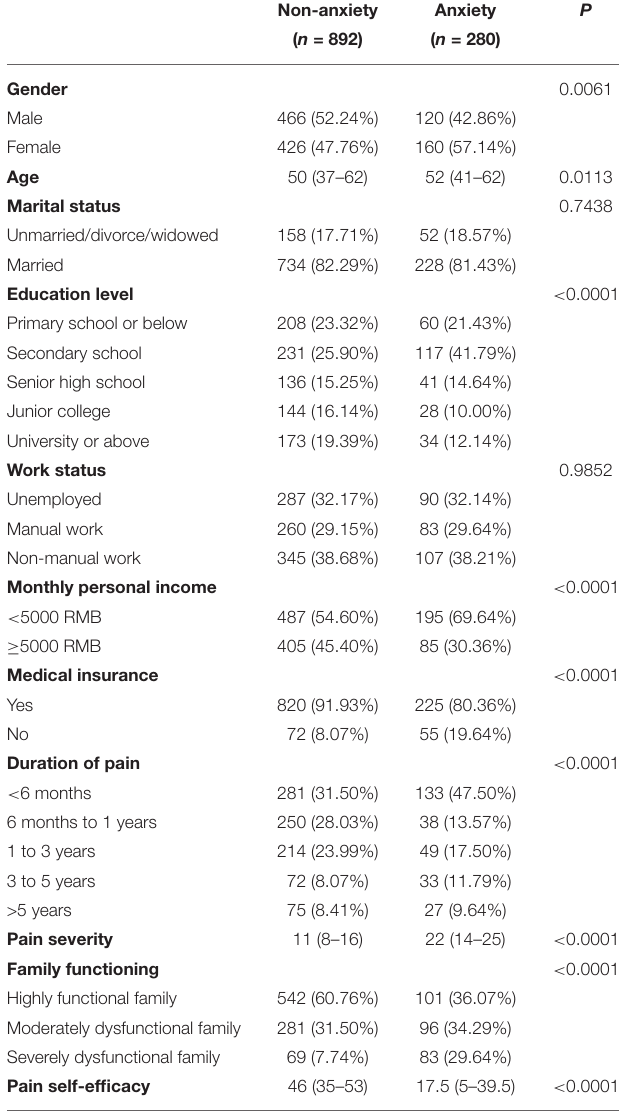
TABLE 1 | The clinical characteristics of chronic low back pain patients in anxiety and non-anxiety